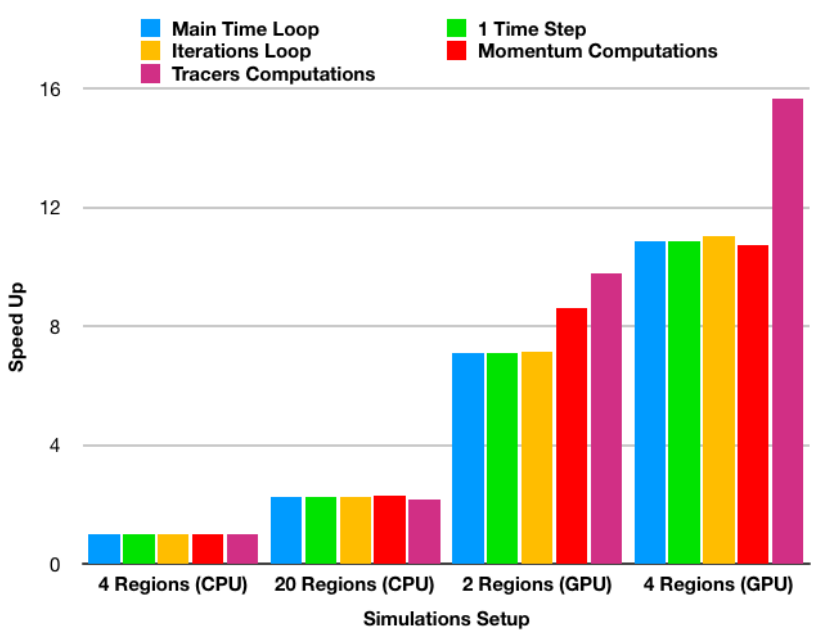
Figure 9. Speed-ups for different procedures for simulations run in ClusterUy.